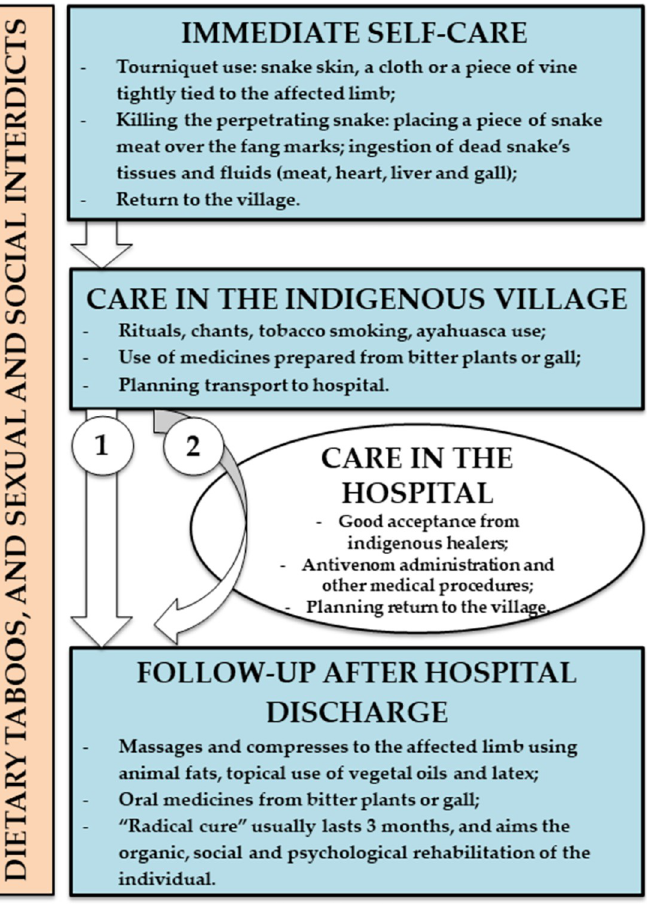
Fig 5. Therapeutic itinerary of an indigenous snakebite patient from the perspective of the indigenous caregivers from the moment of the bite to rehabilitation. Snakebite envenomings occur mostly in the forest, during fishing, hunting and forestry. At this time, self-care practices include the use of tissues of the dead snake that caused the injury. Bitten individuals require immediate transfer to the village, and rituals and plant-derived medicines and bile are part of the therapeutic arsenal. In the community, the therapeutic itinerary may be planned depending on the patient’s severity and the perception of the different actors in the village. In some cases, there may be a refusal to go to the hospital, or there are no means of transport available (1). However, transport of the patient to the hospital is done almost whenever possible (2). In the hospital, the patient will receive medical care, especially antivenom treatment, and then return to the village to continue the treatment with the indigenous caregiver in the rehabilitation phase. Dietary taboos, and sexual and social interdictions are noticed throughout this itinerary.